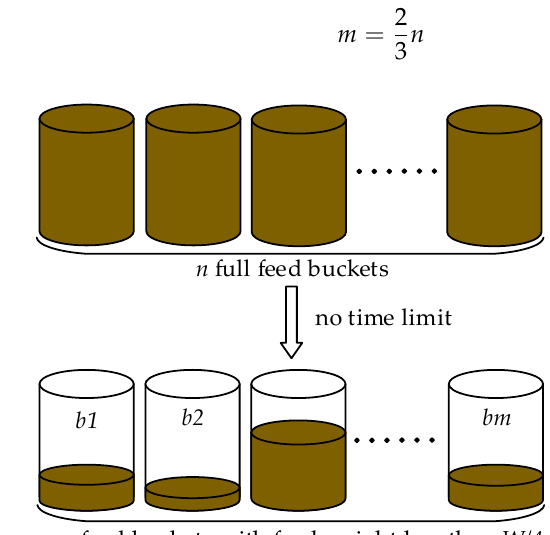
Figure 2. Case 1 for the robot to start feeding.